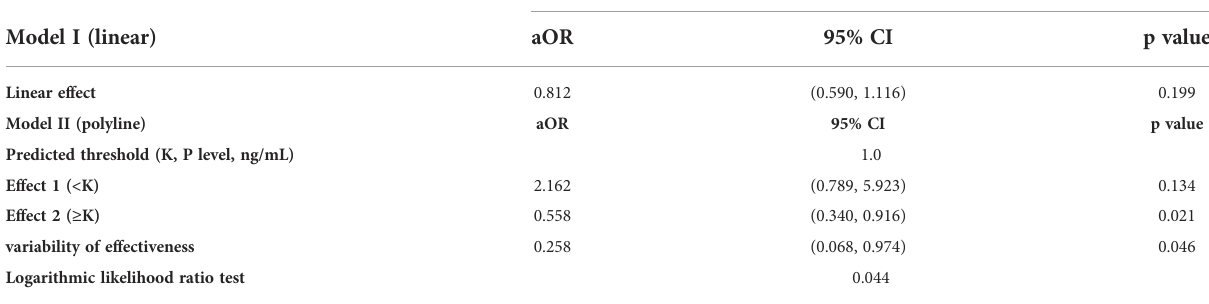
TABLE 2 Threshold effect analysis of serum P level (ng/mL) at the hCG day on the LBR.